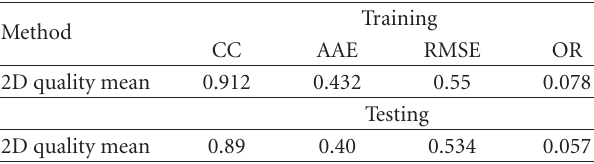
Table 5: Another method’s evaluation results for training and testing.